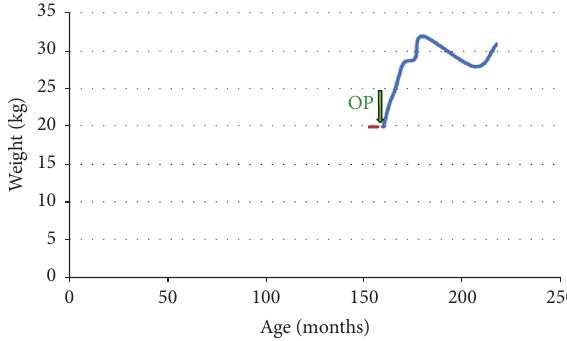
Figure 6: Both jejunal openings were sutured to the peritoneum of the abdominal wall. The guide thread exit site was placed to the right of the wound and the jejunostomy to the left.